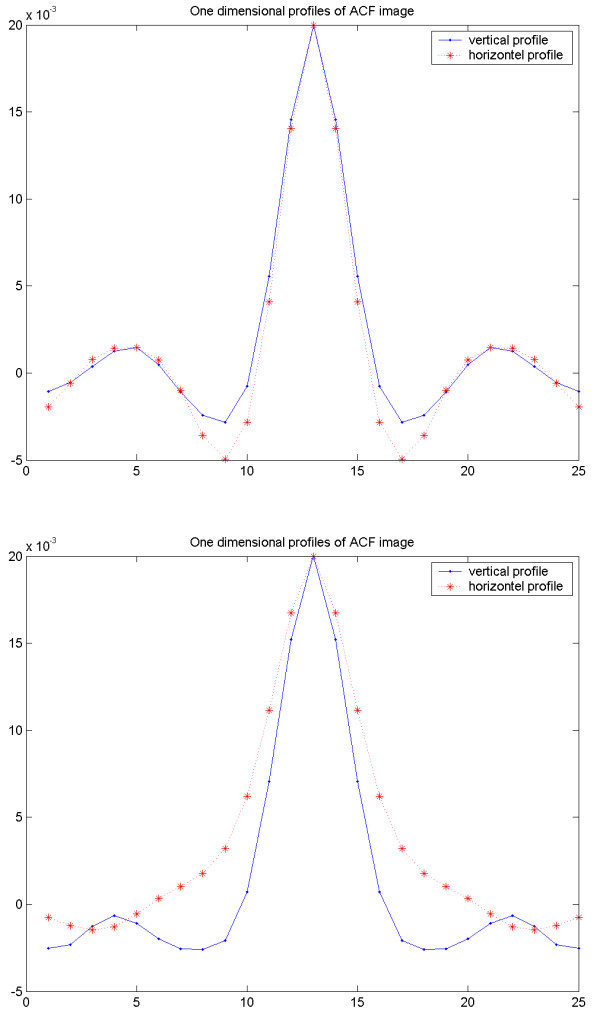
Results of the satellite phantom study. Vertical (dash point) and horizontal profile (dash star) through the centre of the ACF image obtained with 2D (upper) and 3D acquisitions (lower) reconstructed using OSEM with 6 mm Gaussian filter.